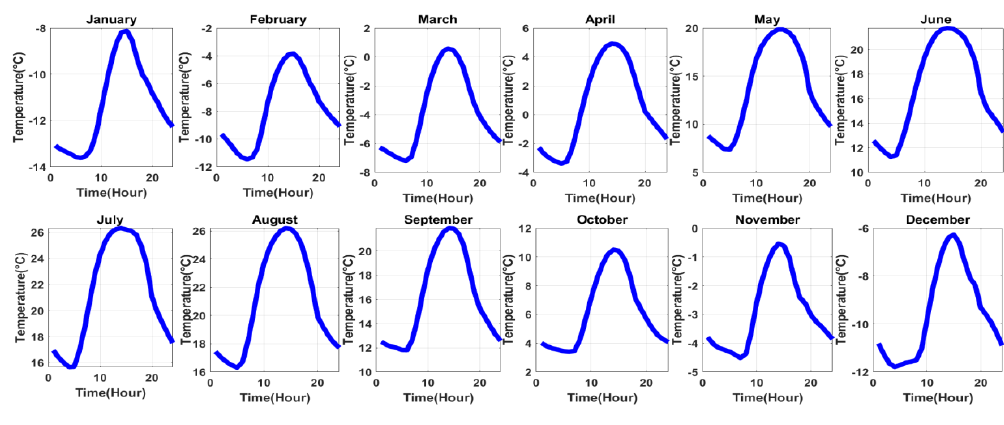
Figure 7. Figure 7. Temperature.